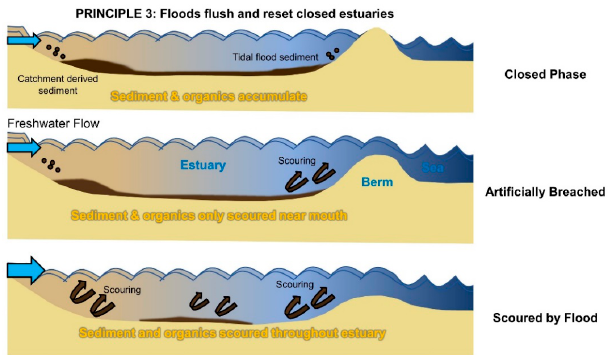
Figure 6. Longitudinal view of a temporarily closed estuary showing the influence of freshwater inflow on the accumulation of sediment and organic matter during closed, artificially breached, and flood-scoured phases.